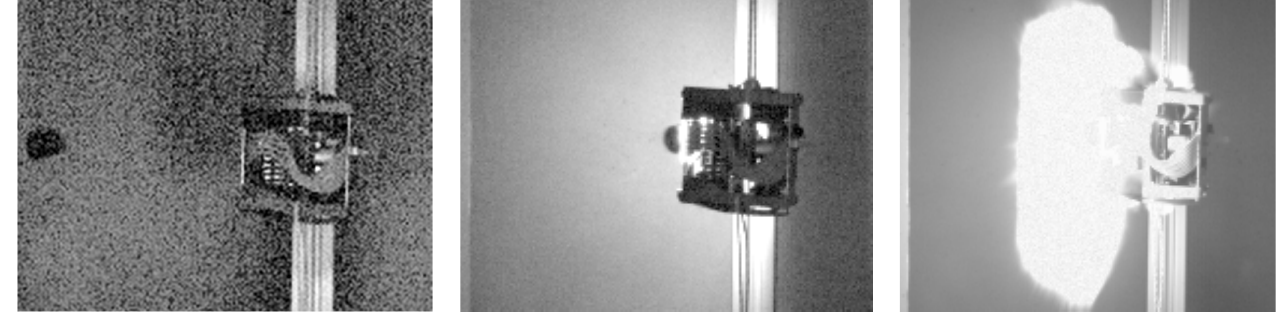
Figure 10. High-velocity camera frames from the impact video: from left to right, projectile approaching the target, collision, and impact flash [47].